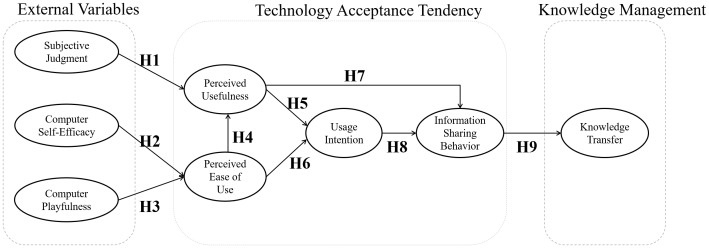
Hypothesis model.